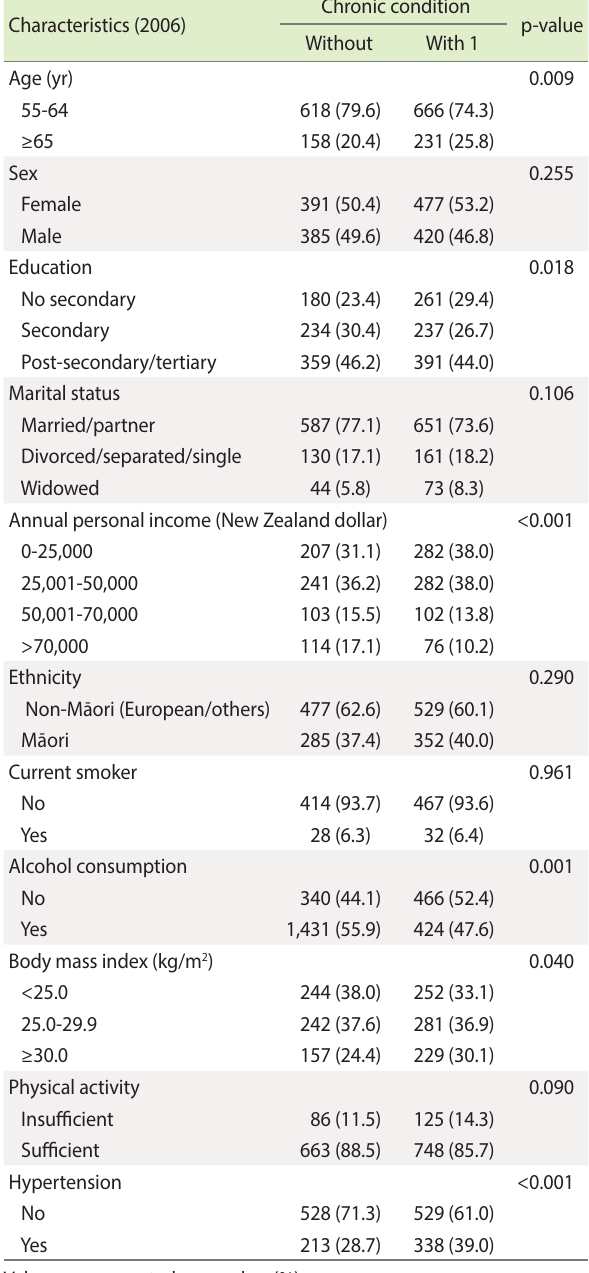
Table 1. Baseline characteristics of adults 55 years of age and older